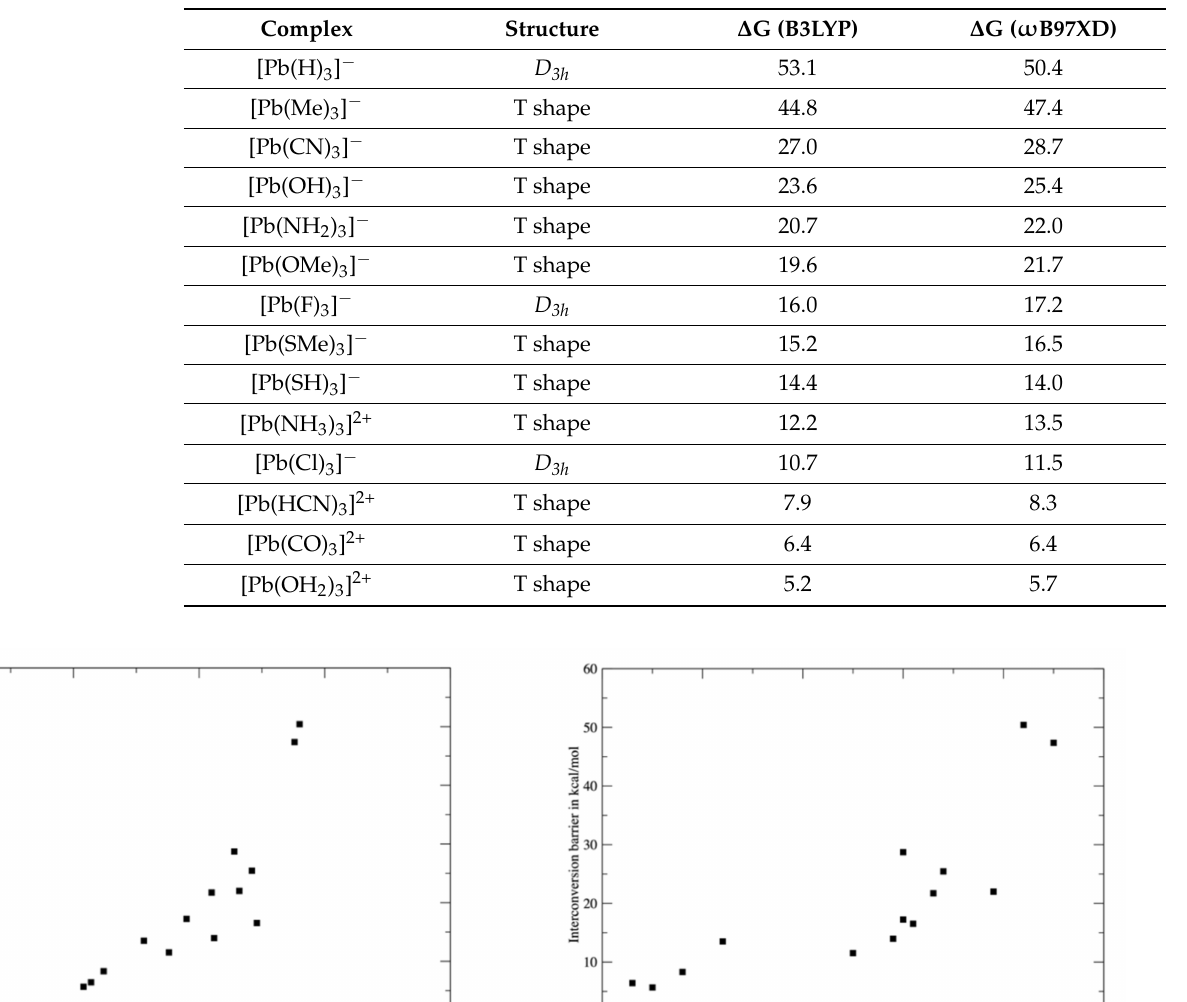
Table 4. General shape and interconversion barriers (in kcal/mol) with B3LYP and ω B97XD functionals.